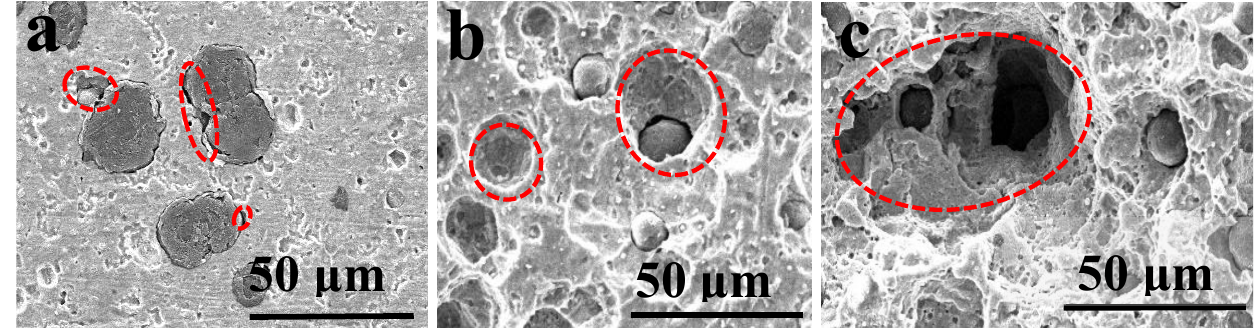
Figure 6. The localized corrosion initiation process in ductile iron ( a – c ).